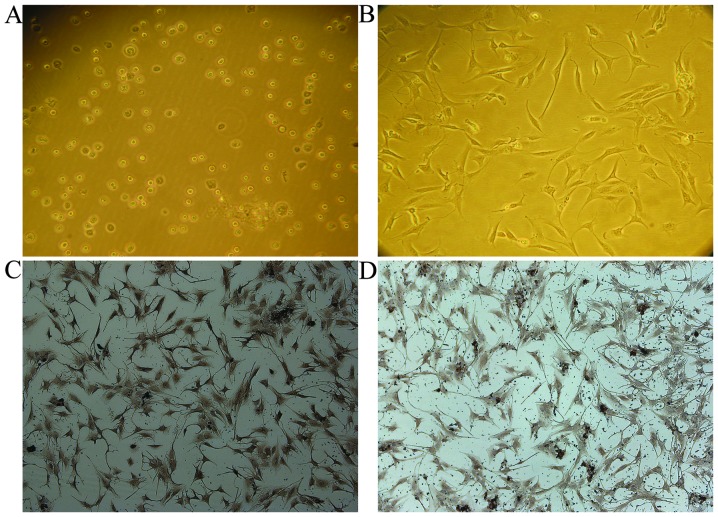
Isolation, culture and identification of primary nucleus pulposus (NP) cells. (A) Primary NP cells were obtained by enzymatic digestion (magnification, ×100). (B) Degenerated NP cells from passage 2 attached to the culture dish after passage for 3 h (magnification, ×100). The primary NP cells derived from degenerative human disc were round at the moment of isolation (A) and they had attached to the culture dish after 5–7 days of culture. The cells gradually became elongated and triangular or polygonal in shape, and the cytoplasm became plump and equally distributed. The number of attached cells exponentially increased. (C and D) Immunostaining revealed that these cells were positive for aggrecan and type II collagen, which are makers of the NP cell phenotype (magnification, ×100).